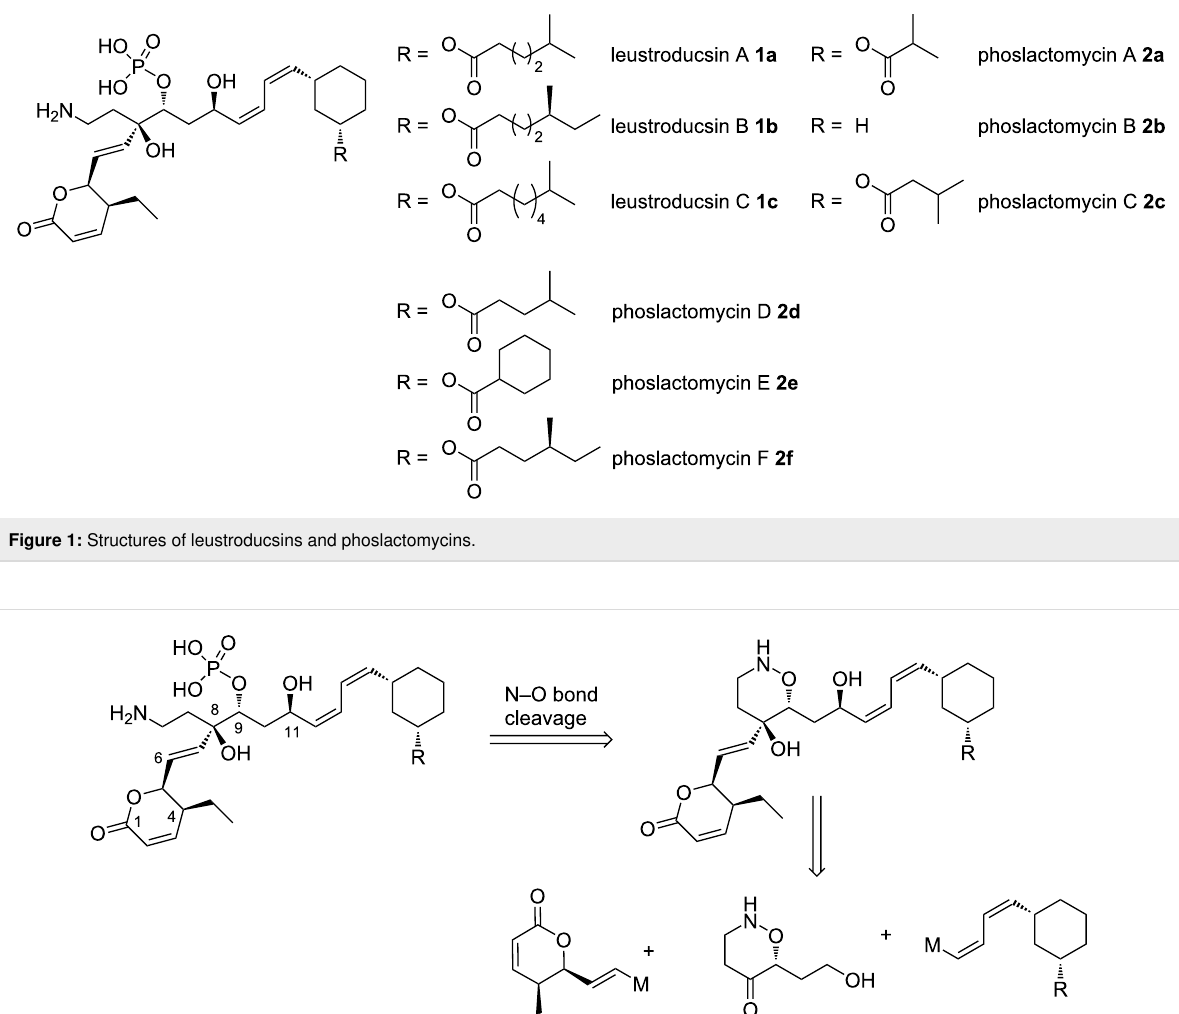
none 4 and attempts for coupling both fragments for the synthe- sis of an advanced